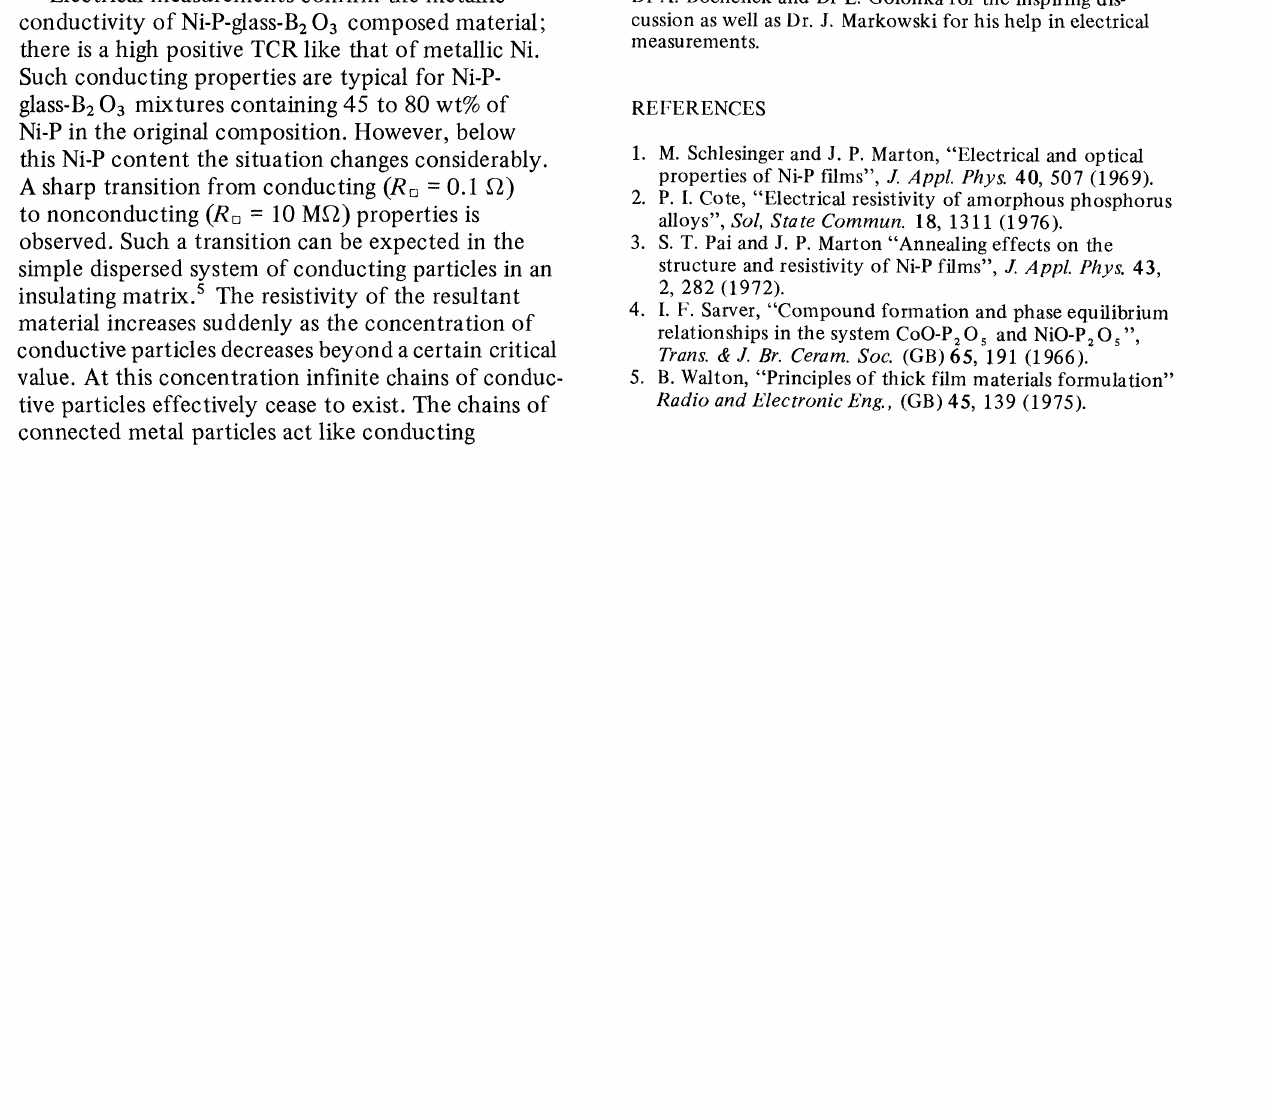
Diffraction patterns of Ni-P-glass (I) and Ni-P- glass-BO (II, III) system samples heated in an air atmos- phere at 350C for 10 min. Ni-P contains 9wt% P (I, III) and 13 wt% P (II). line phases, from which these additional reflections may originate, in the molten